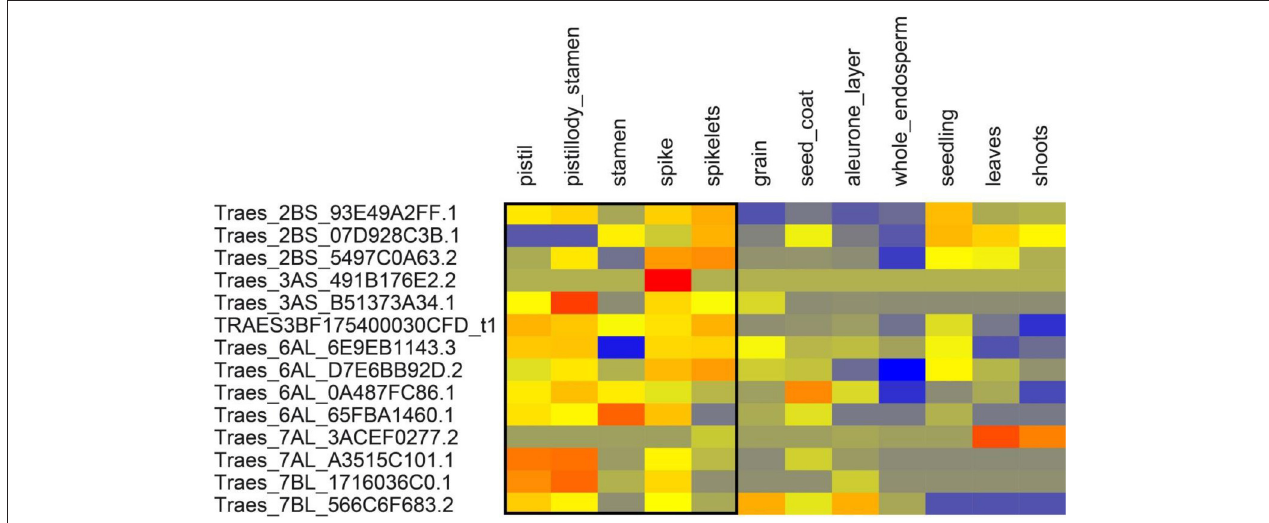
FIGURE 6 | Expression of genes from spring wheat panel in above ground tissues. Expression values are given at log2 scale of transcripts per million (tpm): red, high expression; yellow, moderate expression; blue, low expression. Each individual gene (transcript_ID) is represented as horizontal row and different tissues are described in vertical columns. Tissues from pistil to spikelets show higher expression values for most genes compared to other tissues. Gene expression data were obtained from